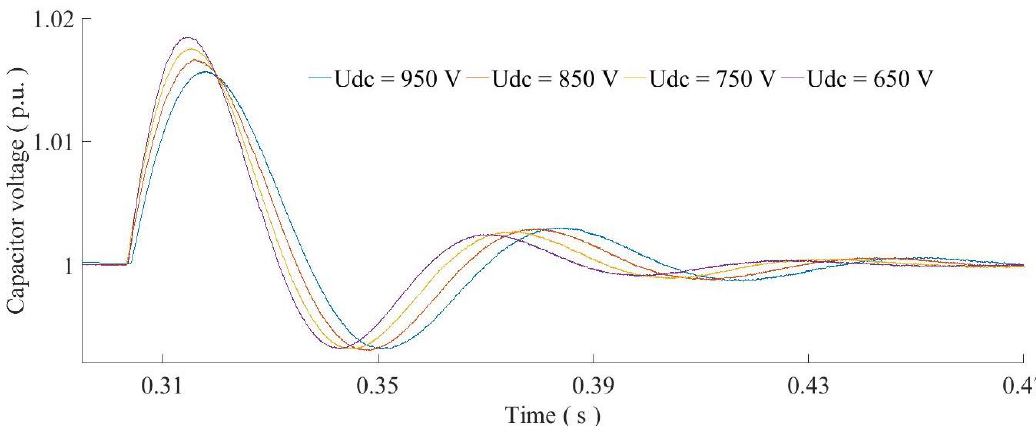
Figure 11. Influence of U dc on the dynamic performance of the DDPS.